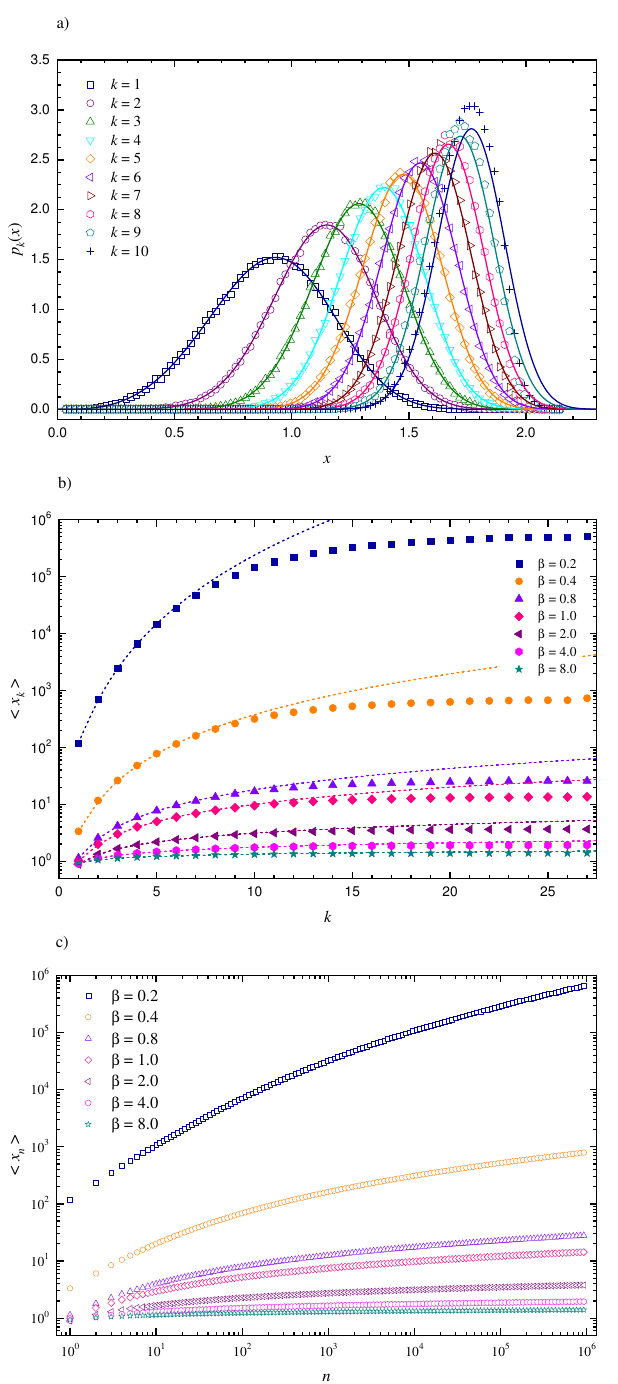
Figure 2. ( a ) The distribution of values of the k th record breaking event, p k ( x ) . Symbols are from Monte Carlo simulations of Weibull random variables with β = 4.0 and τ = 1.0 for sequences of T = 10 6 time steps and averaged over 10 5 realizations. The solid curves are given by Equation (20) for different values of record orders k = 1,2, . . .; ( b ) the mean value (cid:104) x k (cid:105) of the k th record-breaking event versus record order, k . The dashed curves are given by Equation (22); ( c ) the average magnitude, (cid:104) x n (cid:105) , of record-breaking events versus a time step n . The symbols correspond to the numerical evaluation of Equation (24) for the corresponding values of the Weibull